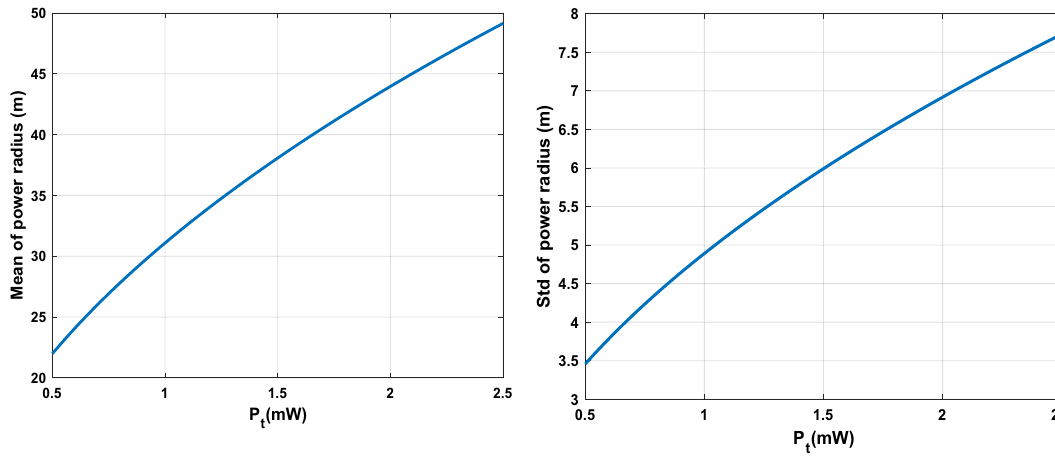
Figure 6. The mean and Std of power radius ( m ) over the power transmitted ( mW ) in [− 3, + 3 ] .